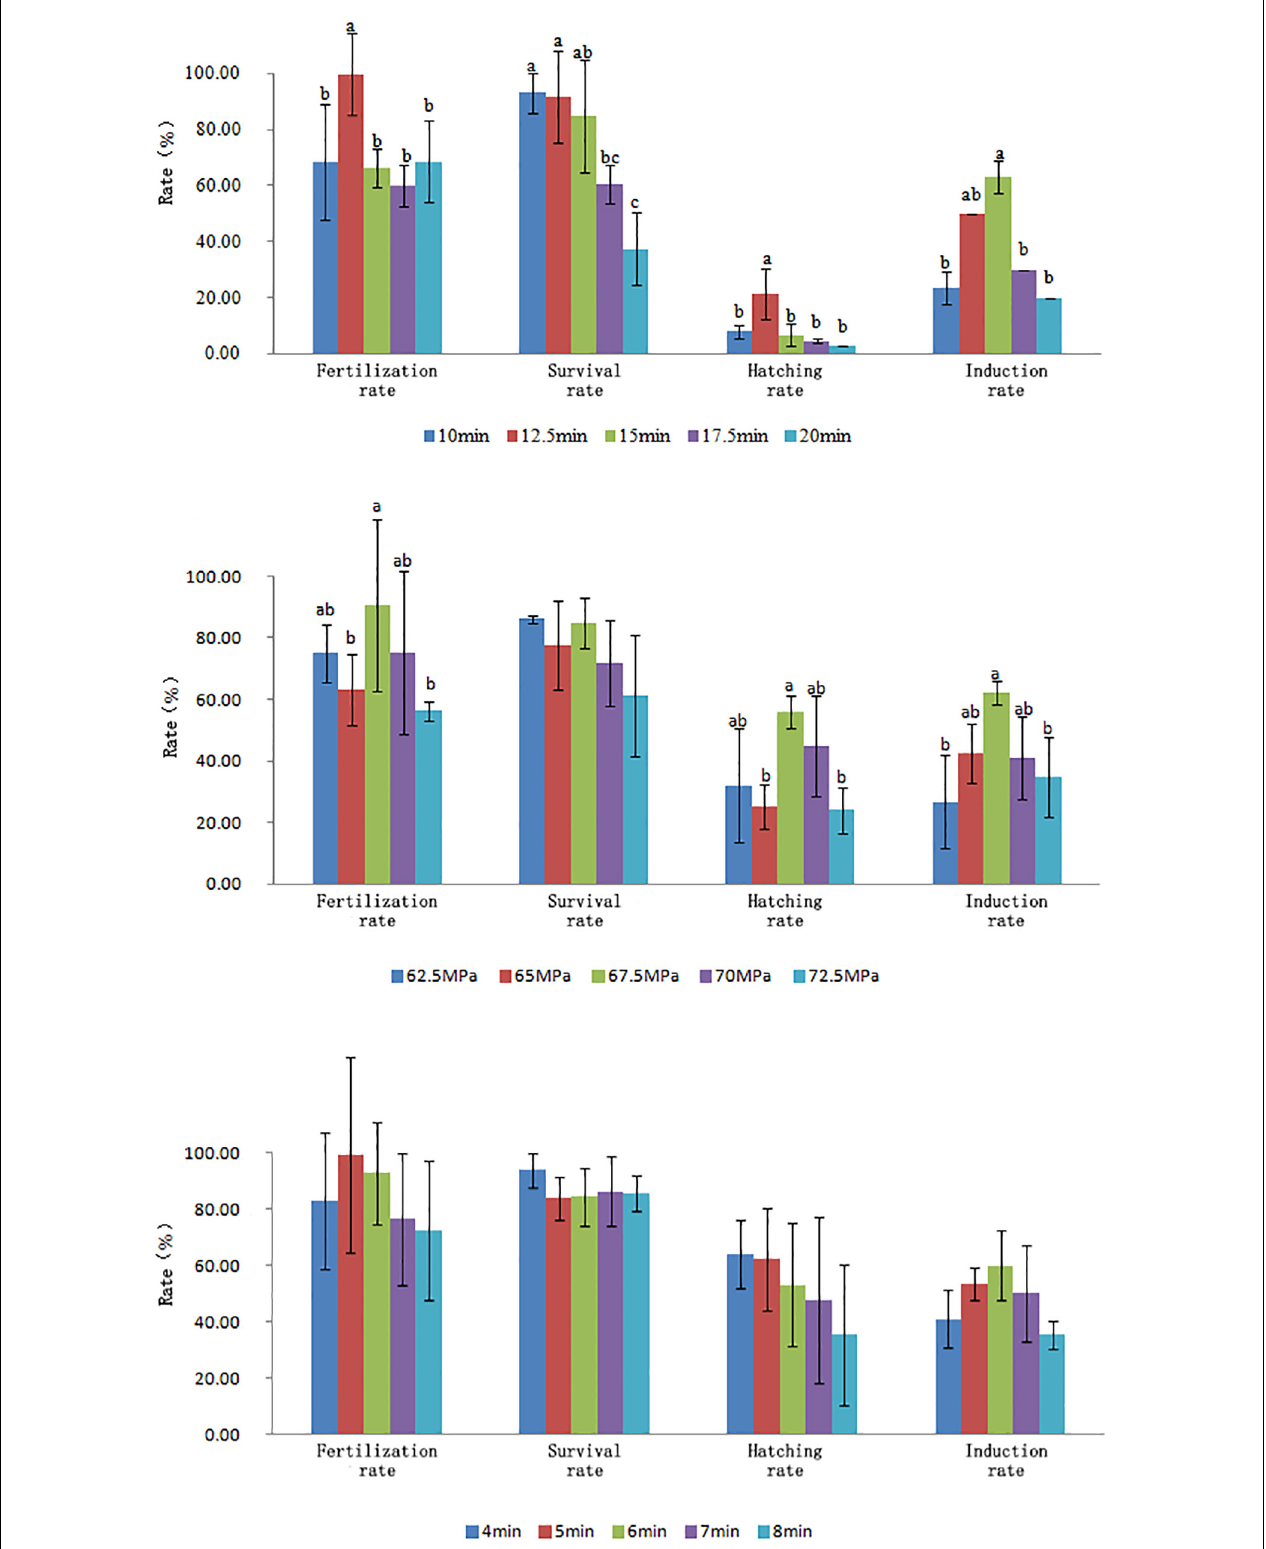
FIGURE 1 | Effects of initiation treatment time, treatment pressure, and treatment duration on fertilization rate, survival rate at gastrula stage, hatching rate, and induction rate.